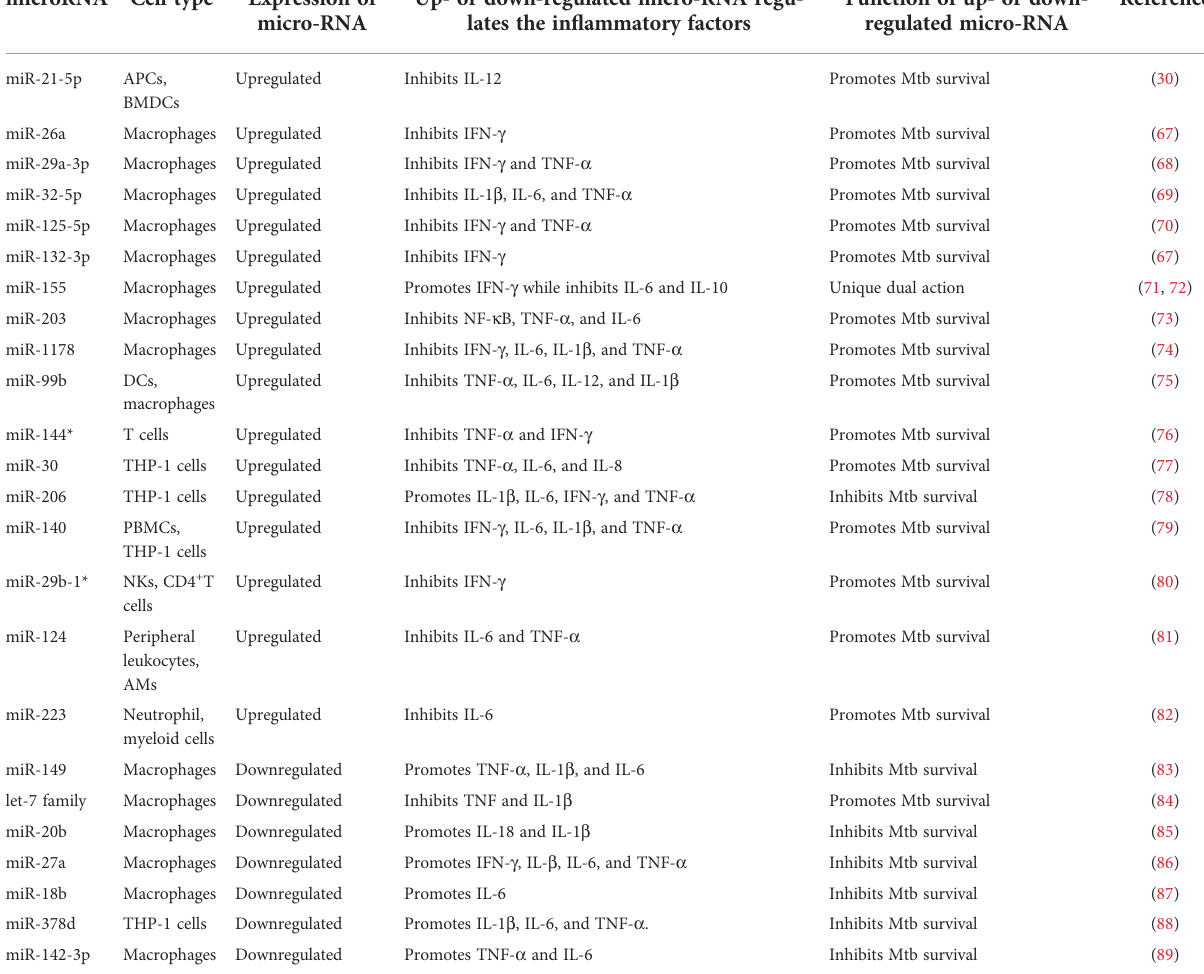
TABLE 1 microRNAs modulate the in fl ammatory response after Mtb